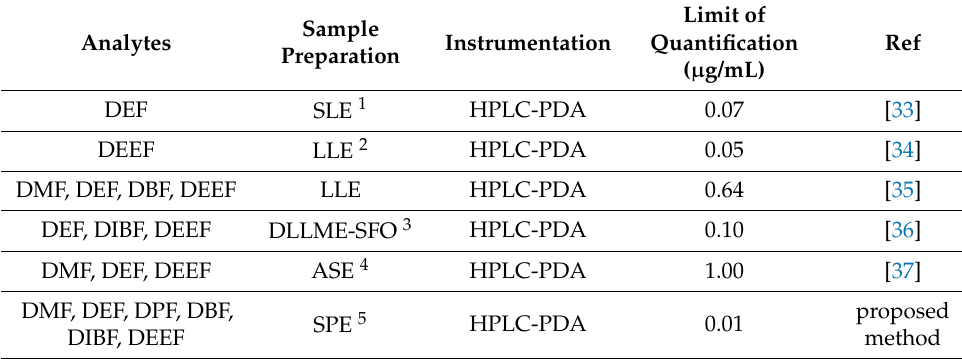
Table 3. Comparison with methods reported in the literature. Sample Analytes Preparation